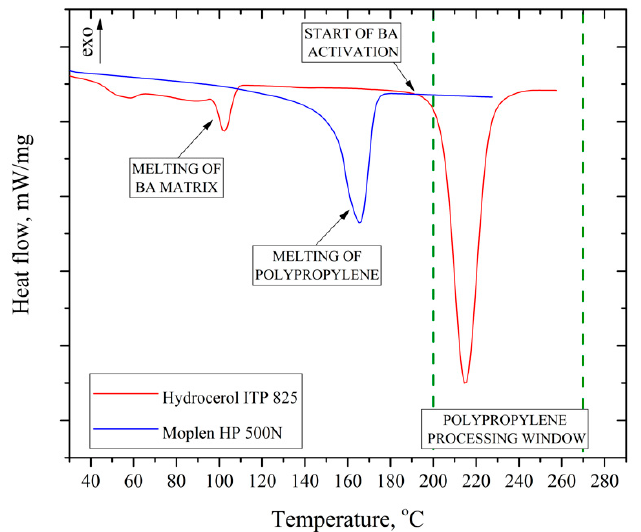
Figure 1. DSC curve of PP and blowing agent (CBA) recorded during heating.